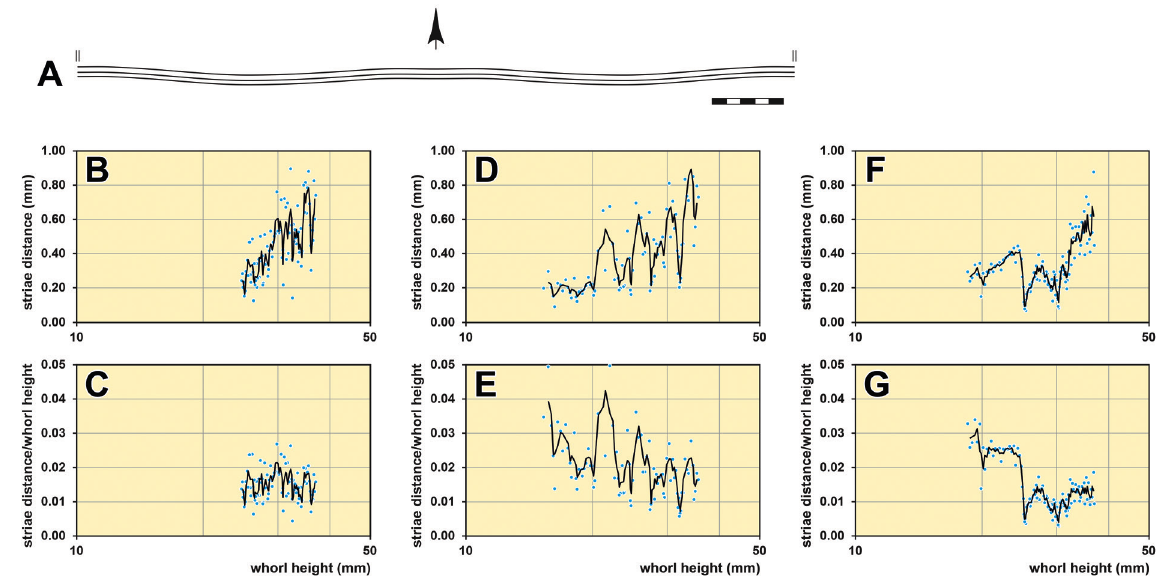
Fig. 16. Rhynchorthoceras kranepuhlense sp. nov. from the Upper Red Orthoceratite Limestone. A . Striae of holotype MB.C.11730 (Kummerow Coll.) from Kranepuhl (Brandenburg), at wh = 16 mm. B–C . Ontogenetic development of striae distance (in mm) and striae distance/whorl height of specimen MB.C.30492 (Neben & Krueger Coll.) from Oderberg (Brandenburg). D–E . Ontogenetic development of striae distance (in mm) and striae distance/whorl height of specimen MB.C.30491 (Neben & Krueger Coll.) from Niederfinow (Brandenburg). F–G . Ontogenetic development of striae distance (in mm) and striae distance/whorl height of holotype MB.C.11730 (Kummerow Coll.) from Kranepuhl (Brandenburg). Blue dots = individual measurements, black lines = three data point averaged values. Scale bar units = 1